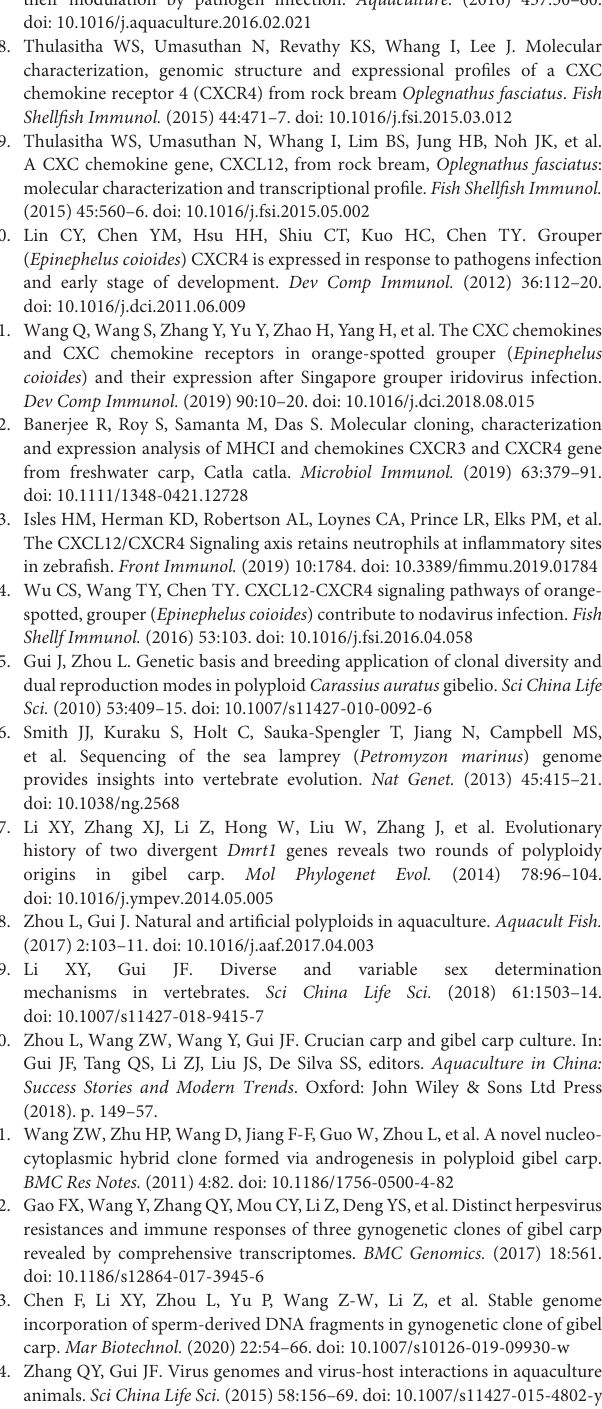
Supplementary Figure 5 | The transfection efficiency and subcellular localization of Cg Cxcr4s. Supplementary Figure 6 | Different Cg Cxcl12 and Cg Cxcr4 combinations activated the activity of Ca IFN promoter.